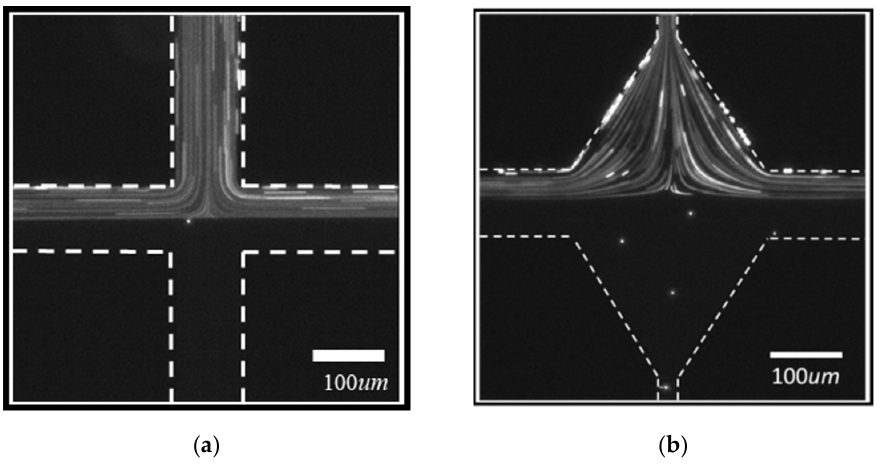
Figure 3. The glycerol flow pattern in the ( a ) SCM and ( b ) RCM at Re = 0.022. Then, we investigated the flow pattern of the viscoelastic fluid in the microchannels.